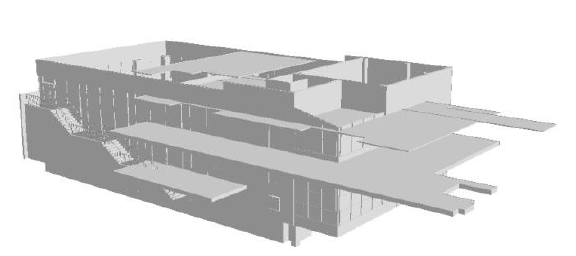
Figure 1 : Horizontal shift of the entire floor of the building